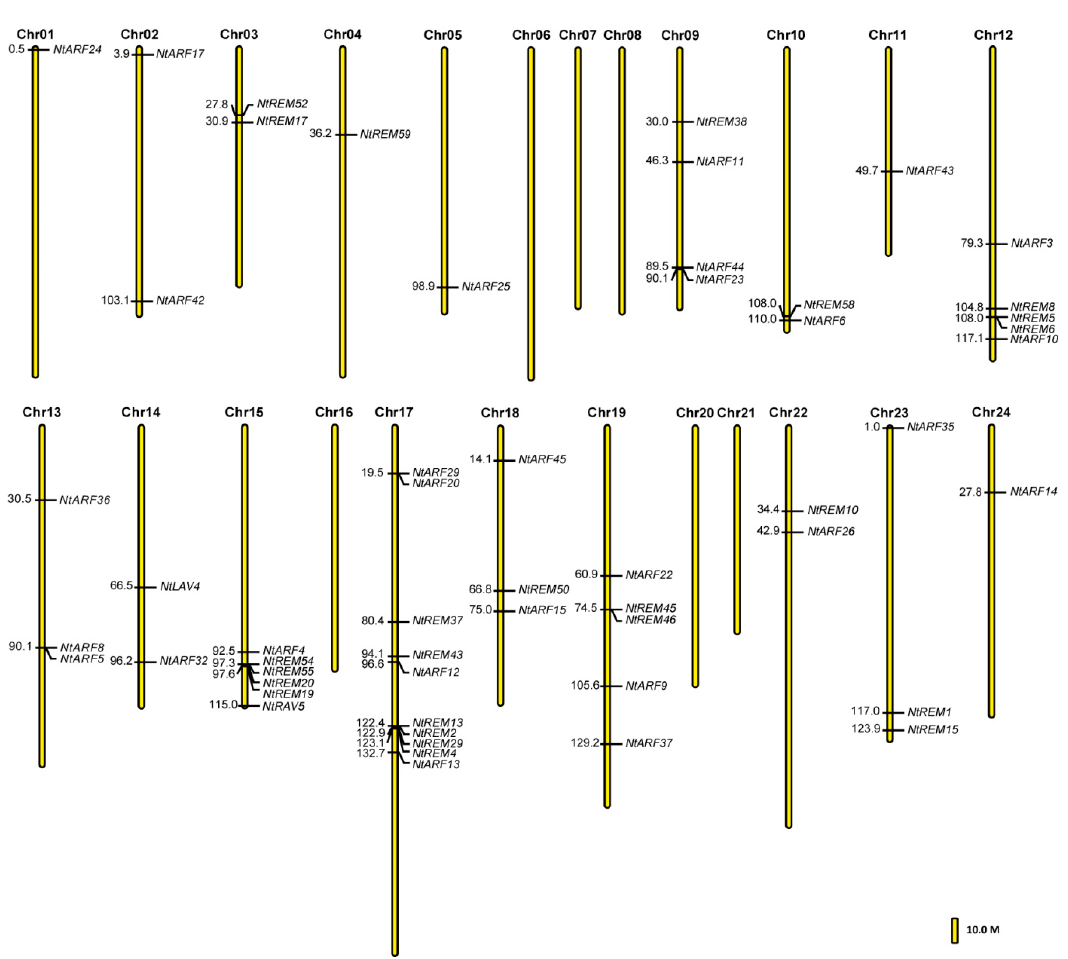
Figure 2. Chromosomal location of tobacco B3 genes based on their physical positions. Bar = 10.0 Mb.